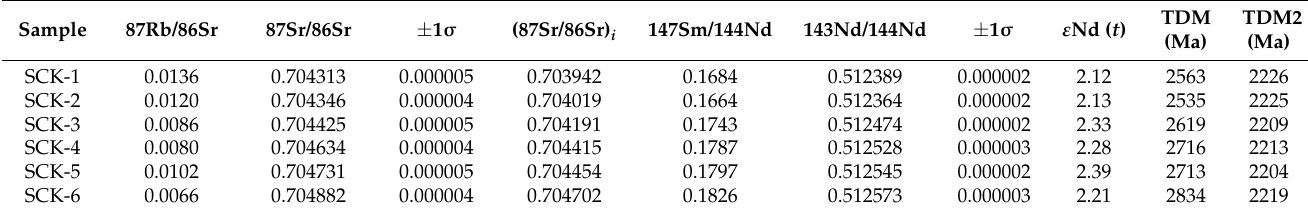
Table 6. The whole-rock Sr-Nd isotopic data of the Sanchakou